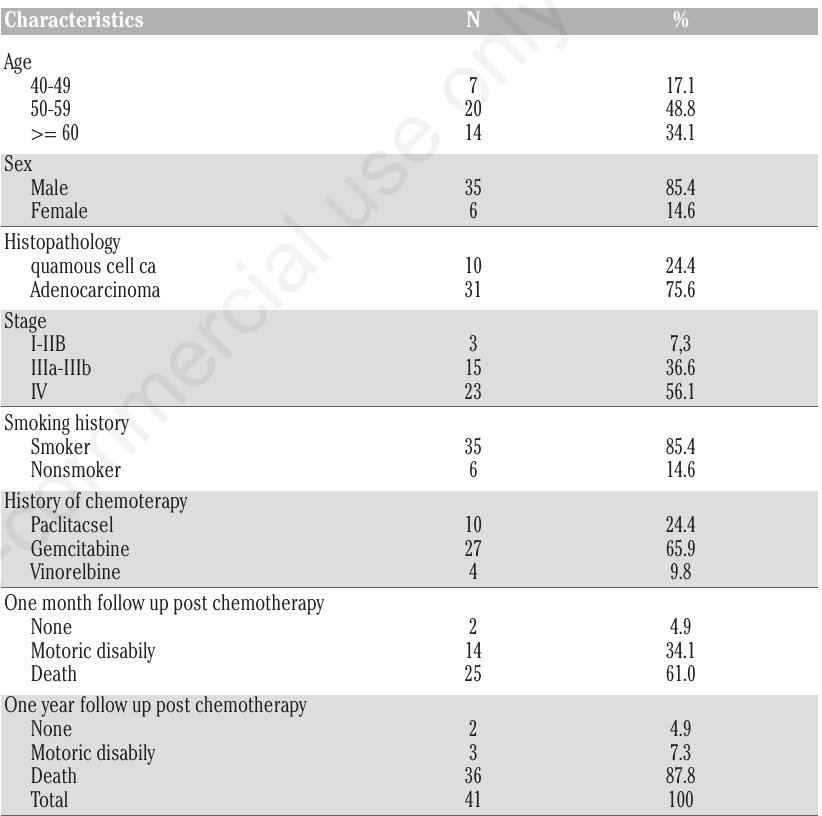
Table 1. General characterics of participants.